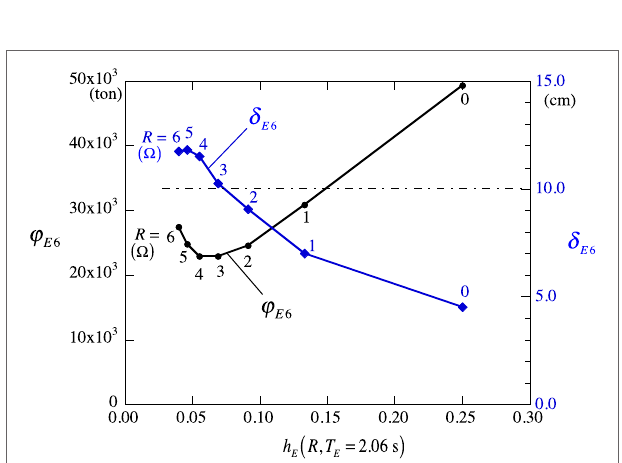
FIGURE 10 | Dependence of inertial mass and maximum amplitude of the sixth story’s tuned electromagnetic inertial mass damper on its damping factor .